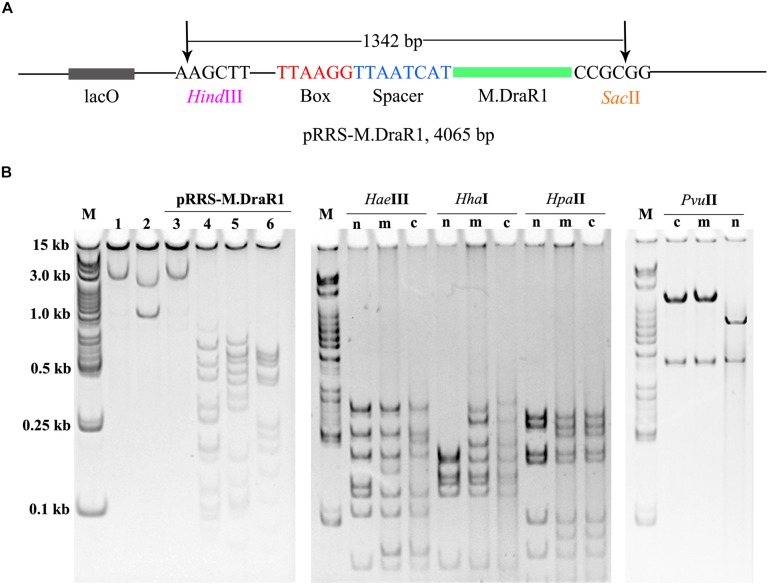
Confirmation of activity of M.DraR1 using methylation protection assays. (A) pRRS – M.DraR1, a high-copy replicon that contains CCGCGG motif and expresses M.DraR1 was constructed. Black arrow stands for the restriction sites of HindIII and SacII, respectively. (B) Analysis of M.DraR1 methylation in vivo. pRRS-M.DraR1 and pRRS null vectors (n) were transformed into methylation-deficient E. coli ER2796 cells, and plasmid DNA were recovered from stationary phase cultures after growth at 37°C for about 20 h. Un-methylated control substrate of pRRS-M.DraR1 was generated by PCR amplification. HindIII predigested pRRS-M.DraR1 from ER2796 (m) (lane 1) prevented digestion by SacII (lane 3), but not by HaeIII (lane 4), HhaI (lane 5), and HpaII (lane 6) in contrast to PCR amplified pRRS-M.DraR1 (c) that is digested by SacII (lane 2). All these substrates showed similar digestive profiles by HaeIII, HhaI, HpaII, and PvuII. M, 250 bp DNA Ladder (TSJ105-100) from Beijing TsingKe Biotech Co., Ltd. All experiments were performed in three independent biological replicates.